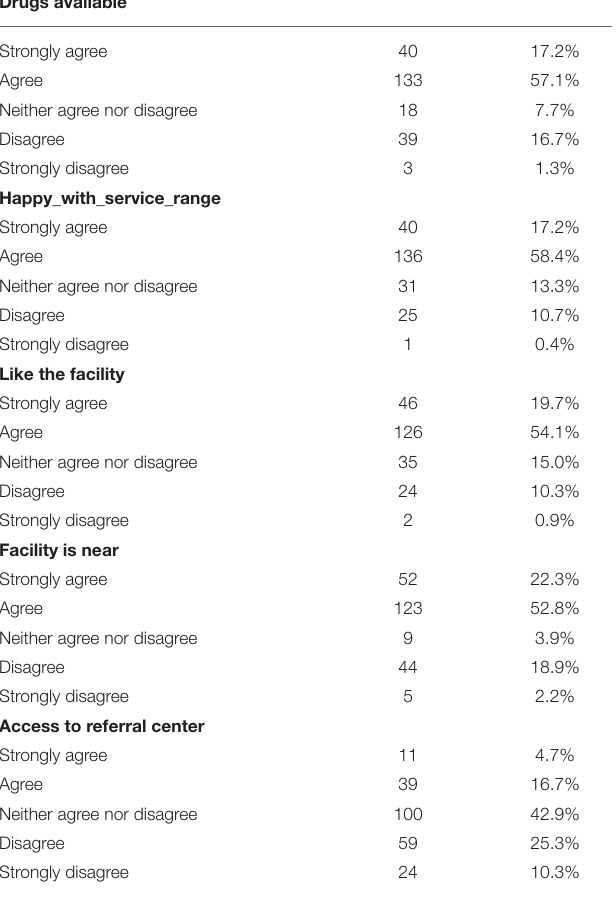
TABLE 4 | Satisfaction of respondents with public health services.